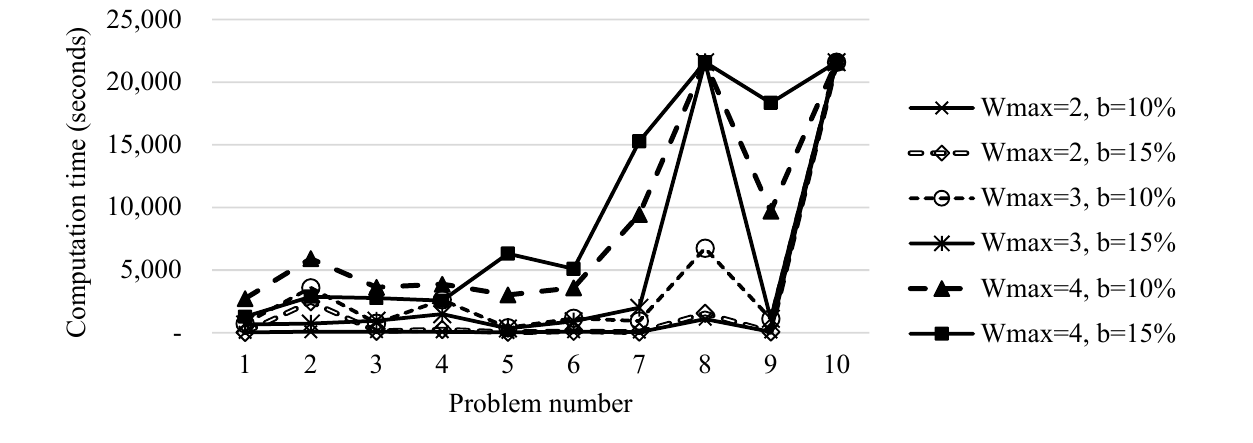
Figure 13. Computation time of LINGO 17. Table 5. Summary of larger